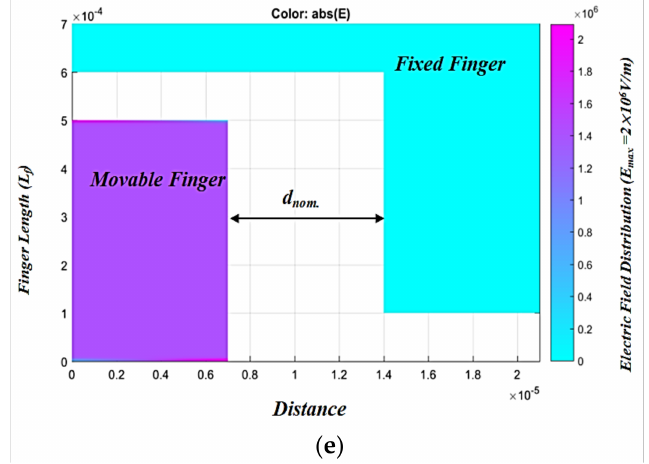
Figure 2. Electric field distribution between the converter fingers at different input voltage, V ip